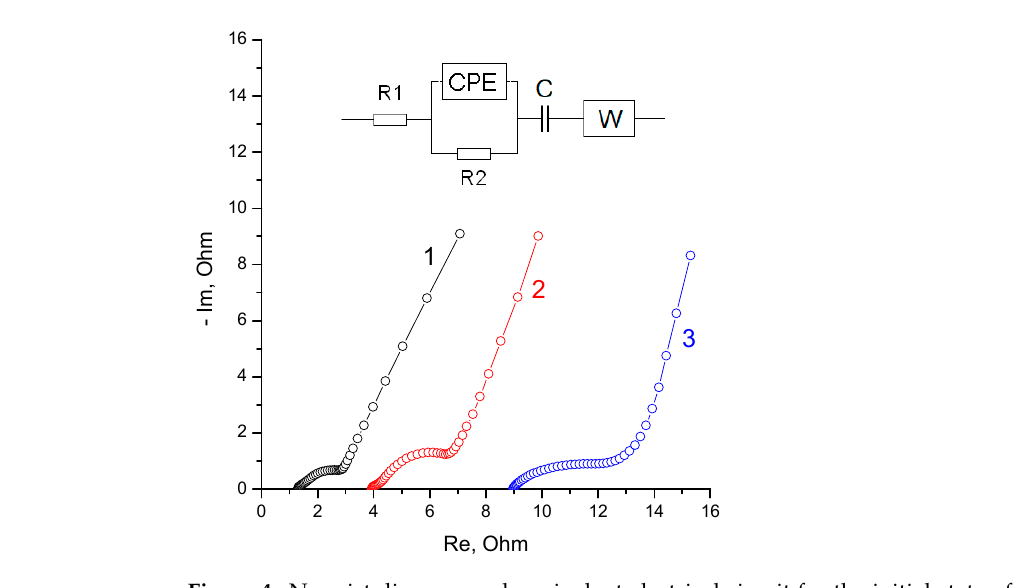
Figure 4. Nyquist diagram and equivalent electrical circuit for the initial state of cells 1, 2 and 3 measured in the frequency range from 100 kHz to 0.01 Hz.